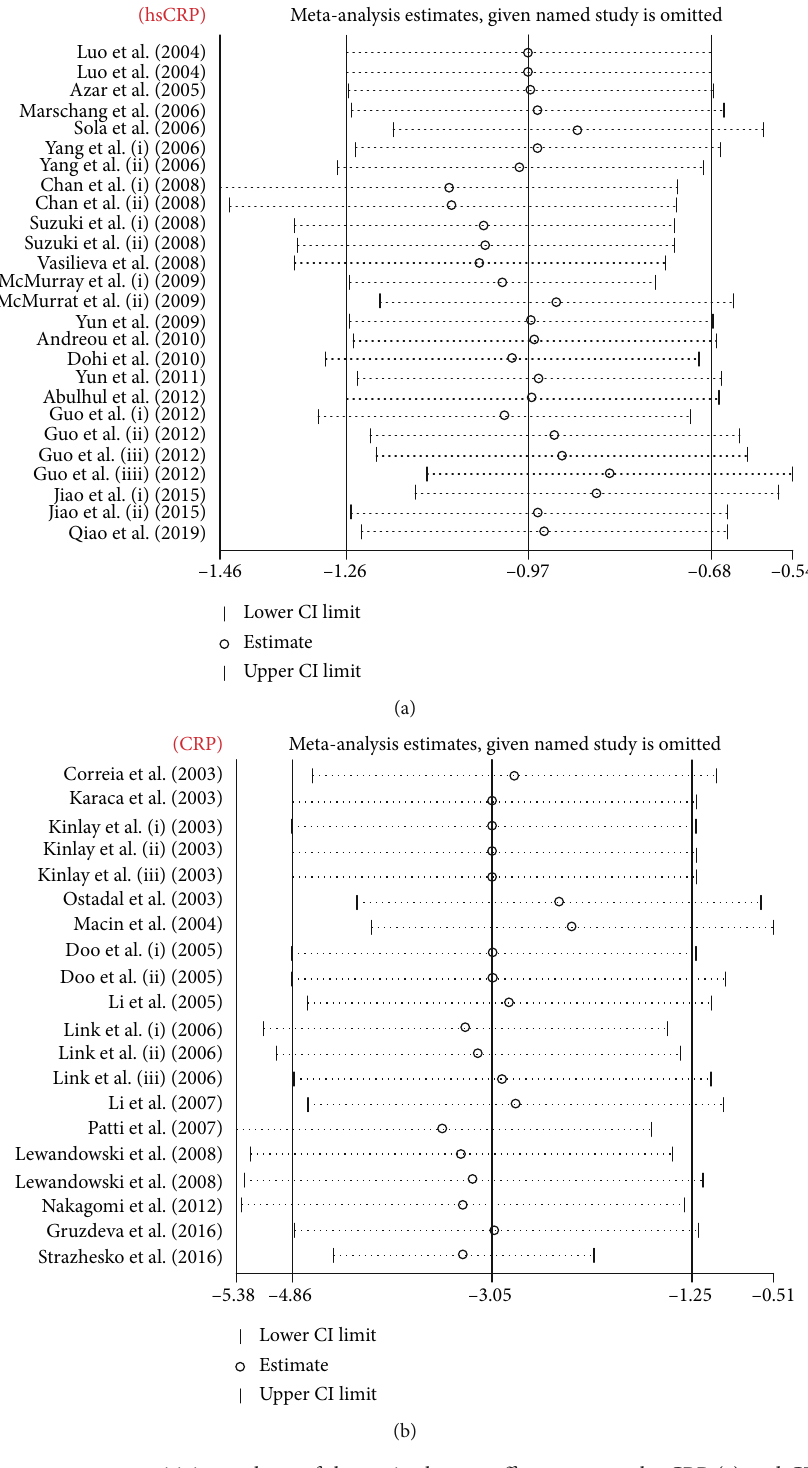
Figure 8: Leave-one-out sensitivity analyses of the statin therapy e ff ect on serum hs-CRP (a) and CRP (b)